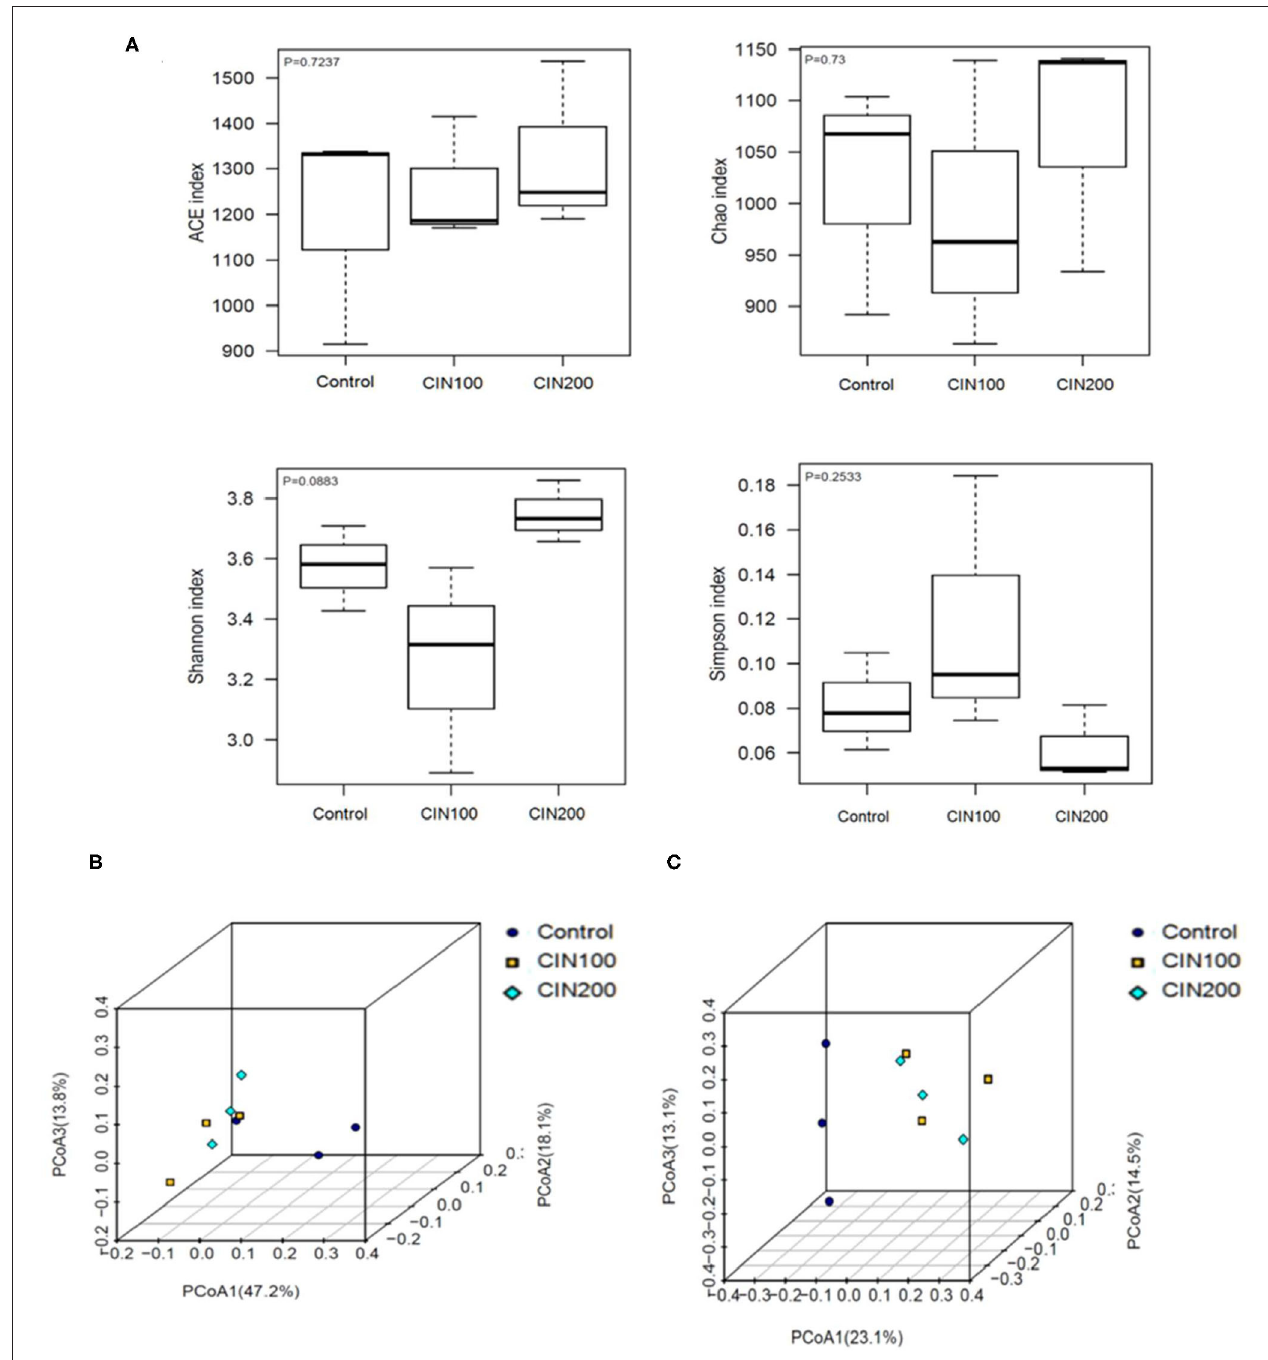
FIGURE 5 | The effects of Cinnamaldehyde supplementation on the α - and β -diversity of gut microbiota communities. (A) Alpha diversity metrics for the gut microbiota treated with cinnamaldehyde. (B) Beta diversity presented as weighted UniFrac distances. (C) Beta diversity presented as unweighted UniFrac distances. One-way ANOVA was carried out for each comparison with HSD